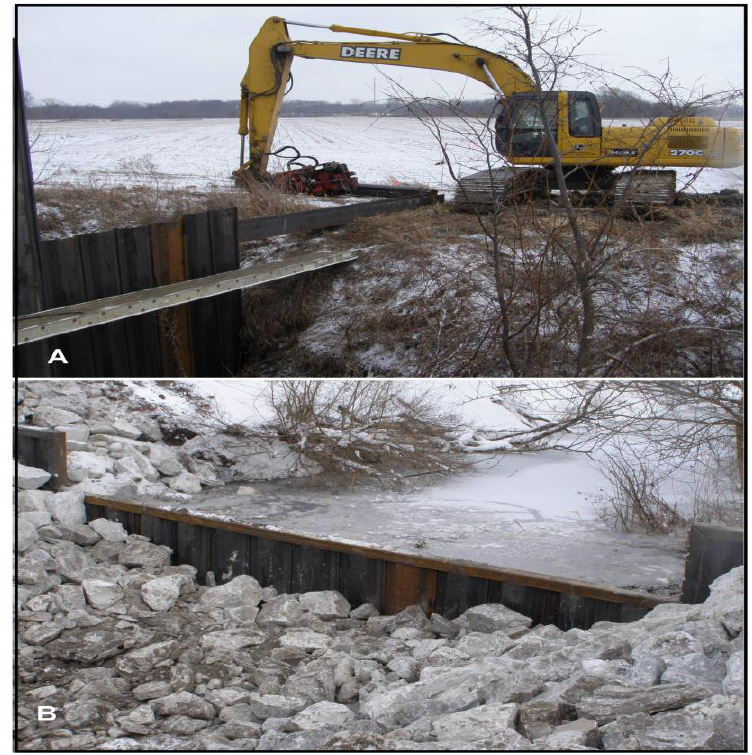
Figure 7. Houghton Lake Hydrologic restoration. As part of the hydrologic restoration, heavy equipment ( A ) was used to install a water control structure ( B ) across the